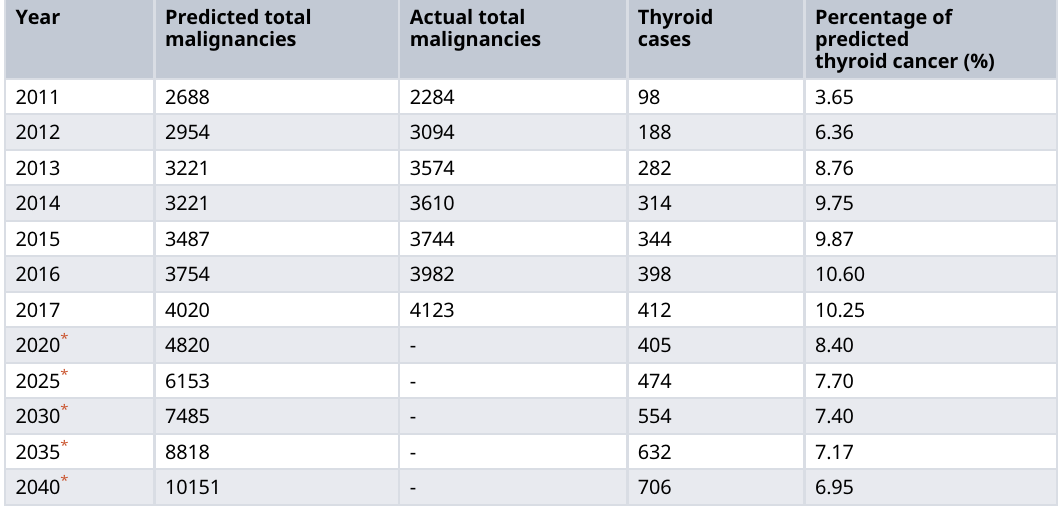
Table 2. Actual and predicted cancer incidence in UAE.